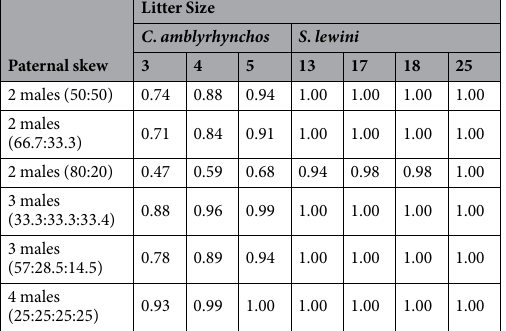
Alleles were amplified in microsatellite suites of 14 and 10 loci for all mothers and pups across 26 grey reef sharks and 91 scalloped hammerheads, respectively (Table 1). H o ranged from 0.094–0.938 in grey reef sharks and 0.545–0.966 in scalloped hammerheads. Polymorphic Information Content (PIC) values were generally high, with 86% and 70% of grey reef shark and scalloped hammerhead loci greater than 0.7 respectively. The probability of detecting multiple paternity (PrDM) was highest for scalloped hammerheads (0.94-1), while probabilities were varied and reduced for grey reef sharks (0.47-1; Table 3). Number of loci had less effect than the number of pups within a litter in the detection of multiple paternity. Multiple paternity was identified in 66% of grey reef shark lit- ters (4 out of 6) and in all scalloped hammerhead litters (all five) (Table 2). The number of putative fathers ranged from 1–3 for grey reef sharks and 2–8 for scalloped hammerheads based on Gerud and Colony estimates. In most cases, Colony analysis detected the same or a higher number of sires than Gerud. Paternal skew was identified in two scalloped hammerhead litters indicating an uneven contribution of pups per sire (Table 2).